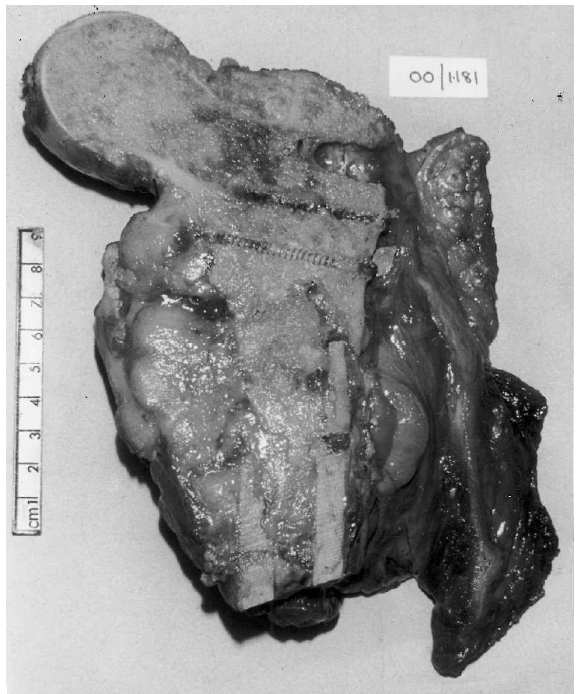
Fig. 2. Gross appearance of the tumour in the proximal femur. The tumour extends along the screw tracts and has infiltrated through the medial cortex into the surrounding soft Fig. 1 . Preoperative radiograph of the proximal femur showing a subtrochanteric pathological fracture and a large, poorly defined lytic and sclerotic lesion.